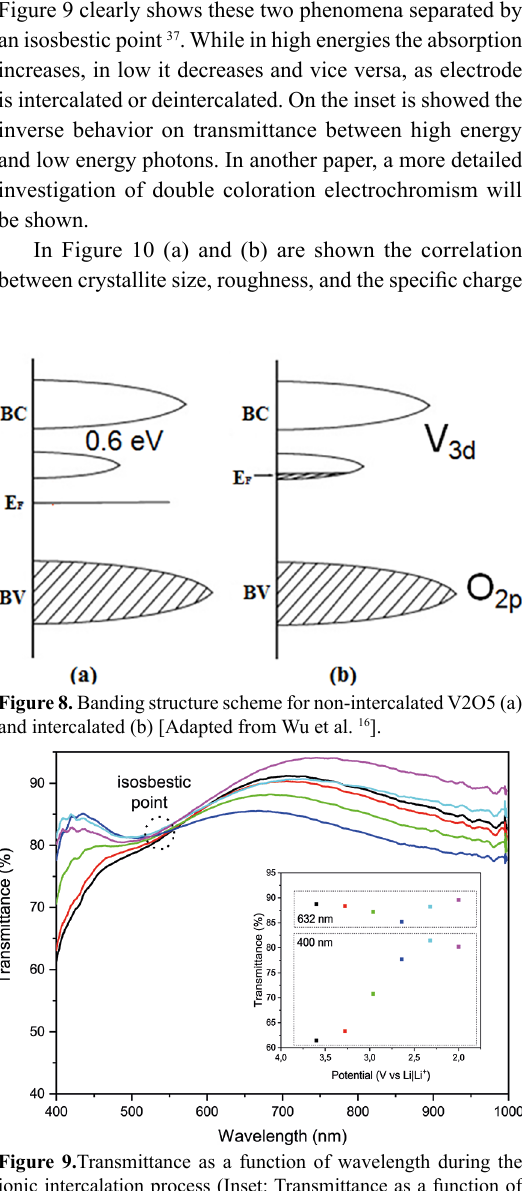
Figure 7. Potential of the cell (black line) and optical transmittance (red line) versus the stoichiometry of Li + intercalated in the films of vanadium oxide.